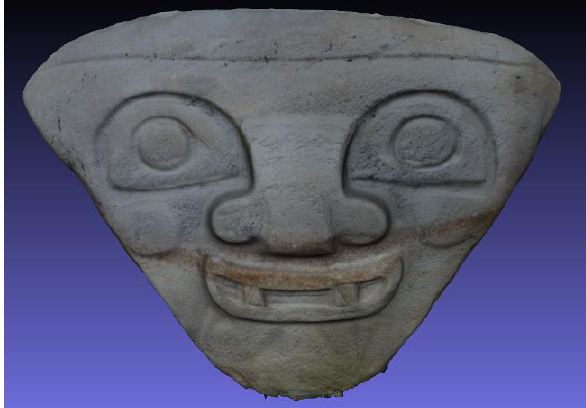
Figure 10. “Escultura 23”. Final colour textured model.